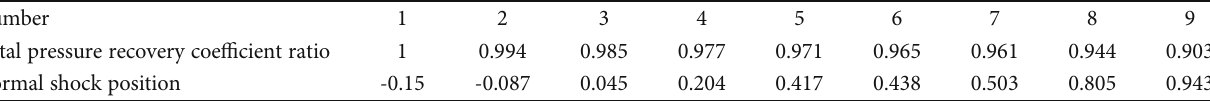
Figure 8: Output of a dynamic transfer function Table 1: Relevant design parameters of the compressor blade.